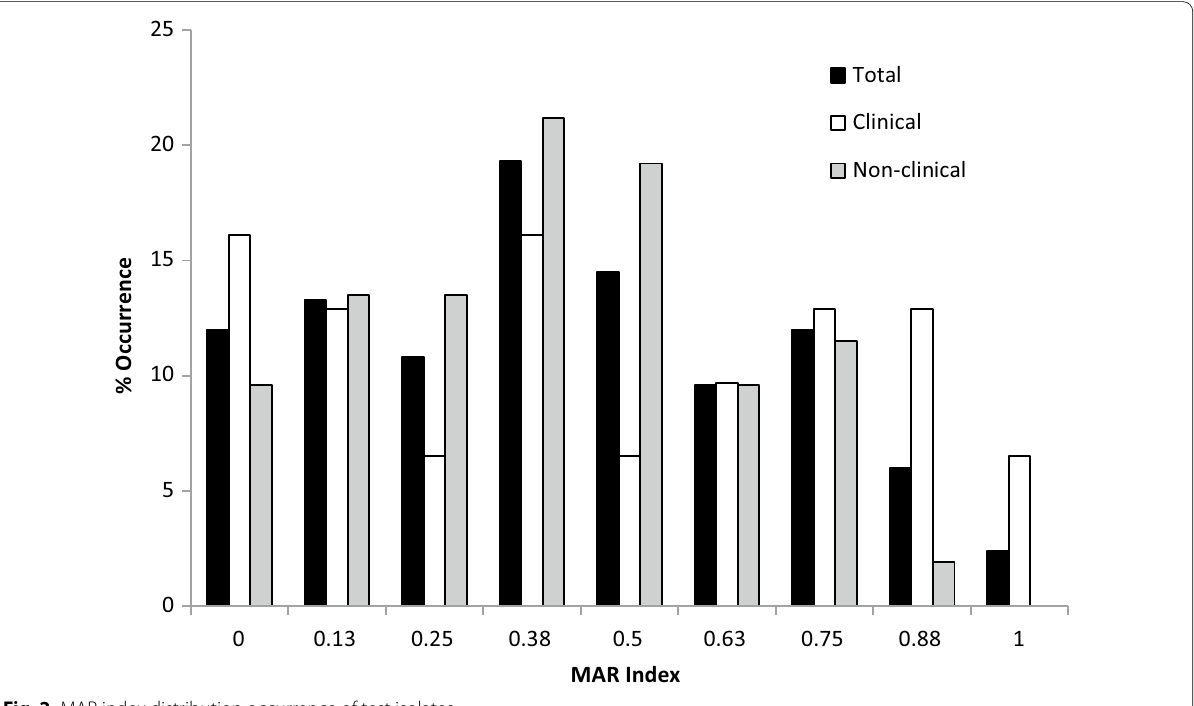
Fig. 2 MAR index distribution occurrence of test